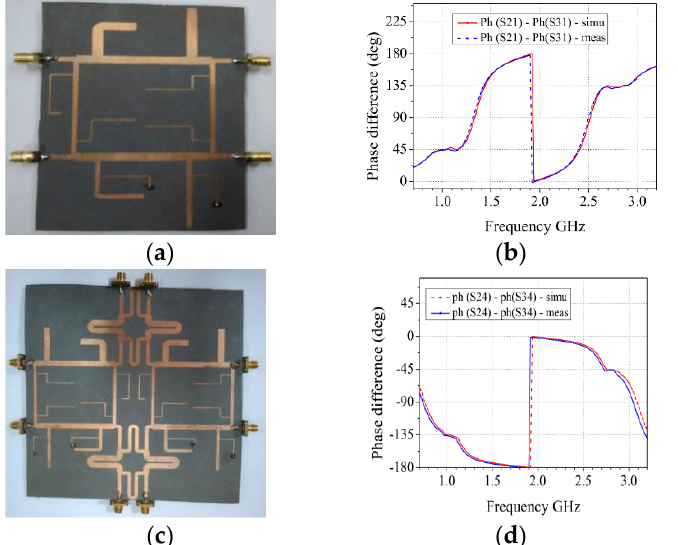
Figure 3. ( a ) The branchline coupler (BLC) prototype; ( b ) simulated measured phase variation of BLC; ( c ) the 4 × 4 Butler matrix prototype; ( d ) measured and simulated phase difference of 4 × 4 Butler matrix [24].